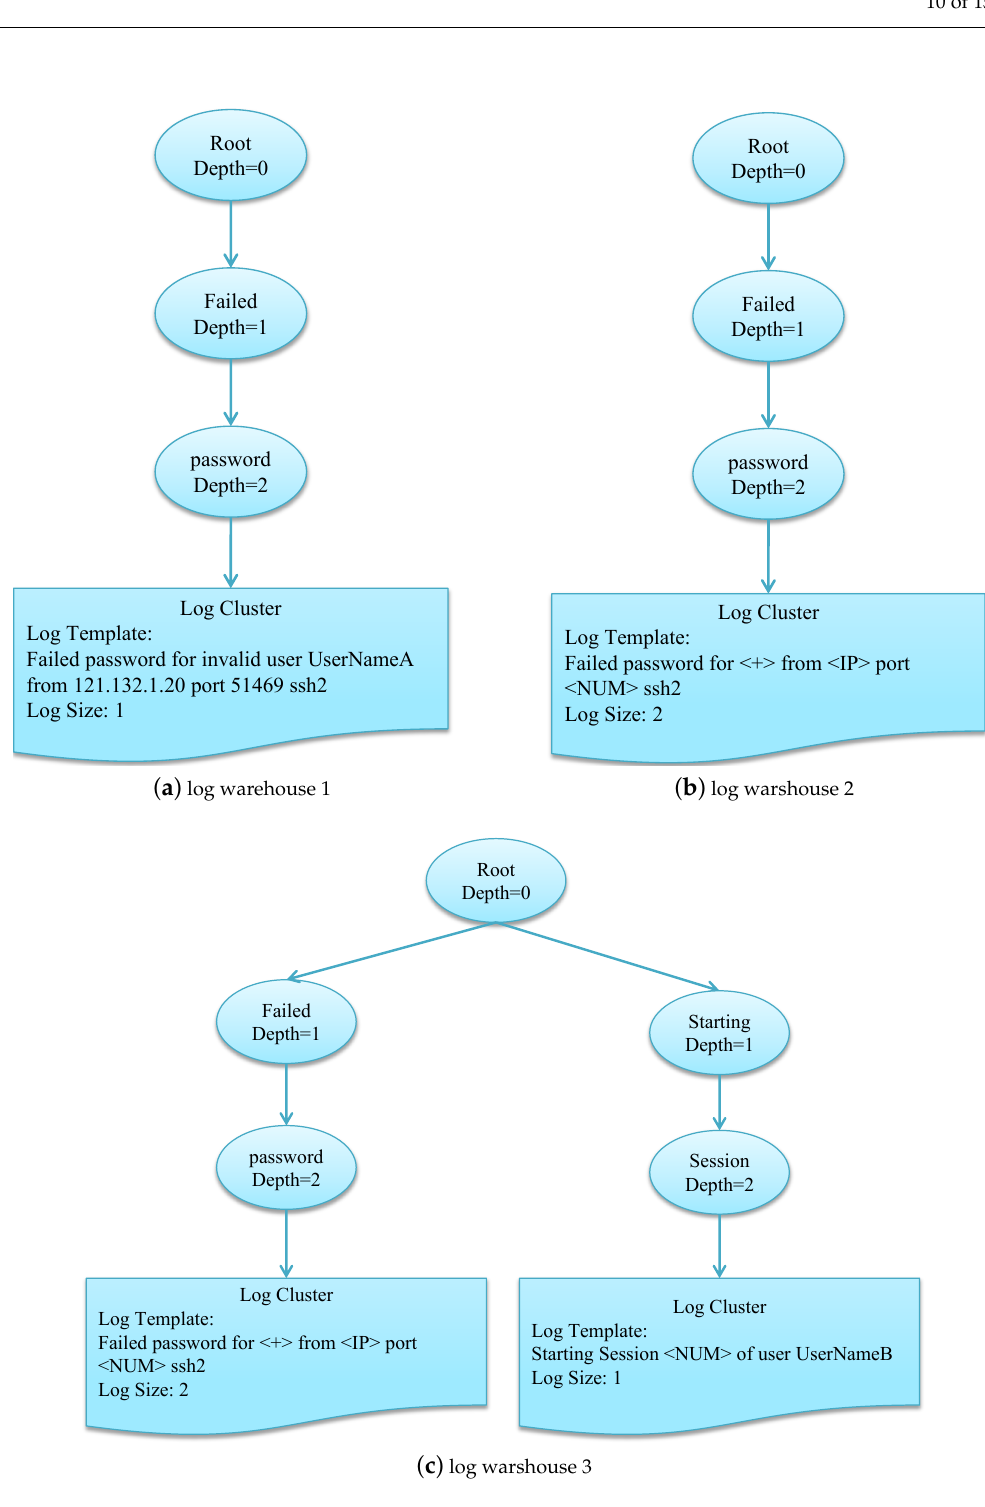
Figure 3. The Example for constructing A Log